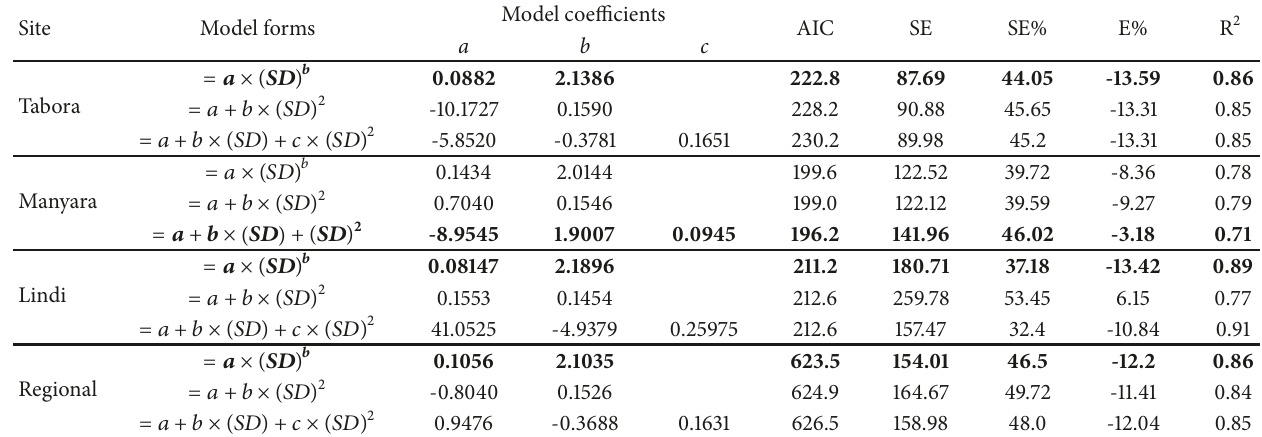
Table 6: Belowground biomass model coefficients and performance.